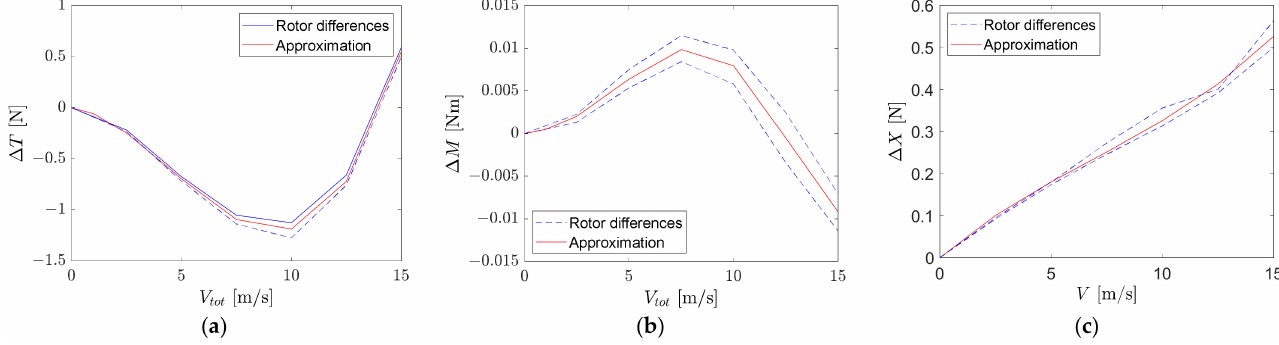
Figure 6. Correction factors of ( a ) thrust, ( b ) torque, and ( c )